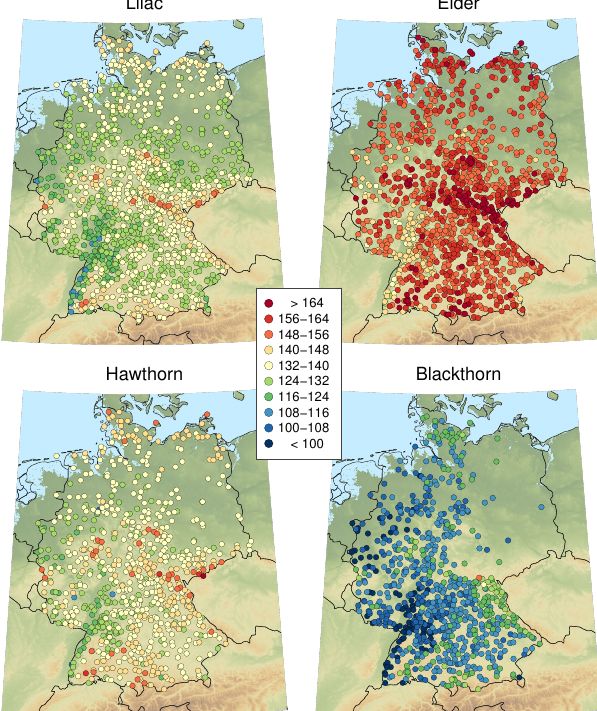
Figure 1. Mean flowering dates (Julian days) of the four analysed shrub species. The figure only shows those records that contain at least 40